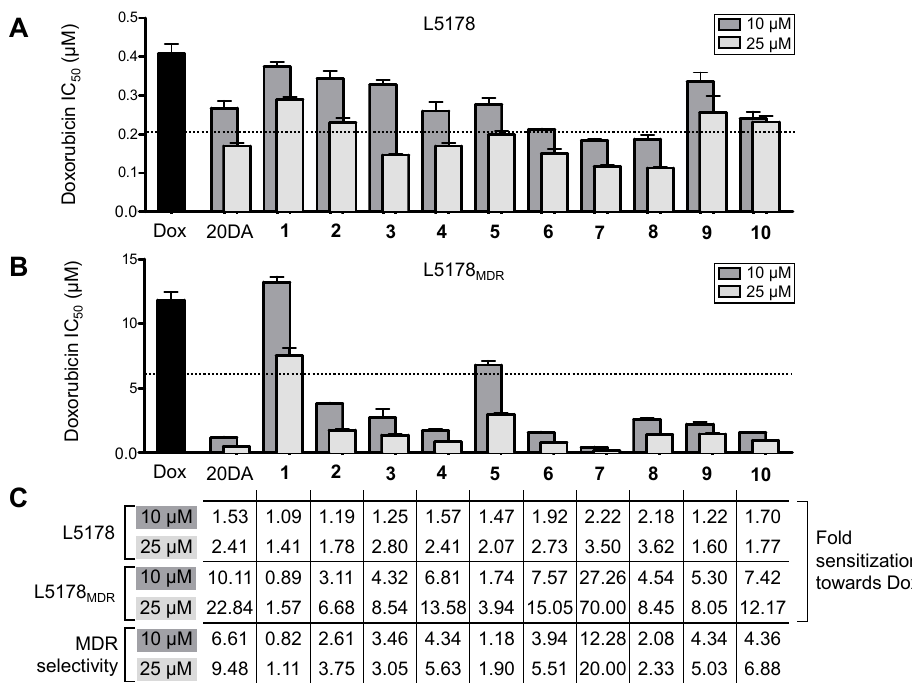
Figure 3. Chemo-sensitizing activity of compounds 1 – 10 on the two lymphoma cell lines. ( A , B ) Show the IC 50 value of doxorubicin (Dox) alone or in combination with 10 or 25 μ M of 20-hydroxyecdysone 2,3;20,22-diacetonide (20DA) or compounds 1 – 10 . The dashed line marks the threshold of two-fold sensitization. With the exception of 10 μ M of compound 1 (either cell line), and 2 , 3 , and 9 (L5178), all IC 50 values differ from that found for Dox alone at p < 0.01 by means of one-way ANOVA followed by Dunnett’s post-hoc test; IC 50 values and levels of significance are provided as supporting information (Table S1); ( C ) Fold sensitization on both cell lines is presented, corresponding to how many times a certain concentration (10 or 25 µ M) of the tested compound decreased the IC 50 of Dox as compared to when it was used alone; MDR selectivity refers to the ratios of the IC 50 values on the resistant and sensitive cell line: MDR selectivity = IC 50 (L5178 MDR )/IC 50 (L5178).